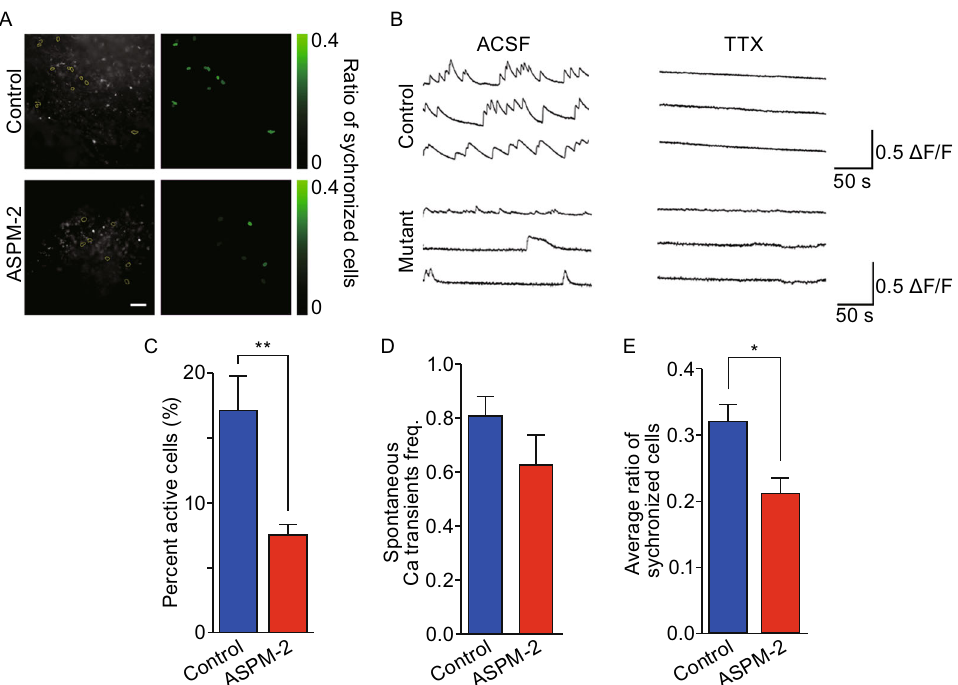
Figure 5. Calcium imaging results of control and mutant organoids. (A) Representative images of synchronized calcium activity of cells in control and ASPM-2 organoids. (B) Representative traces before and after TTX-treated in control and mutant organoids. (C) Percentage of active cells in control and ASPM-2 organoids, n = 8, 9 trials for control and ASPM-2 groups. (D) Average spontaneous calcium transients of single cells in control and ASPM-2 organoids, n = 78, 47 cells for control and ASPM-2 groups. (E) Averaged ratio of synchronized cells in control and ASPM-2 organoids, n = 5, 5 trials for control and ASPM-2 groups. All data are presented as means ± s.e.m. * P < 0.05; ** P < 0.01. Scale bar: 50 μ m in